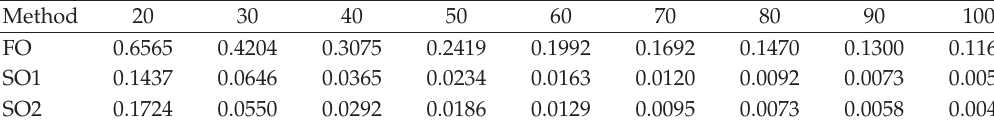
Table 5: Comparison of errors (cid:4) E 2 (cid:5) for approximate